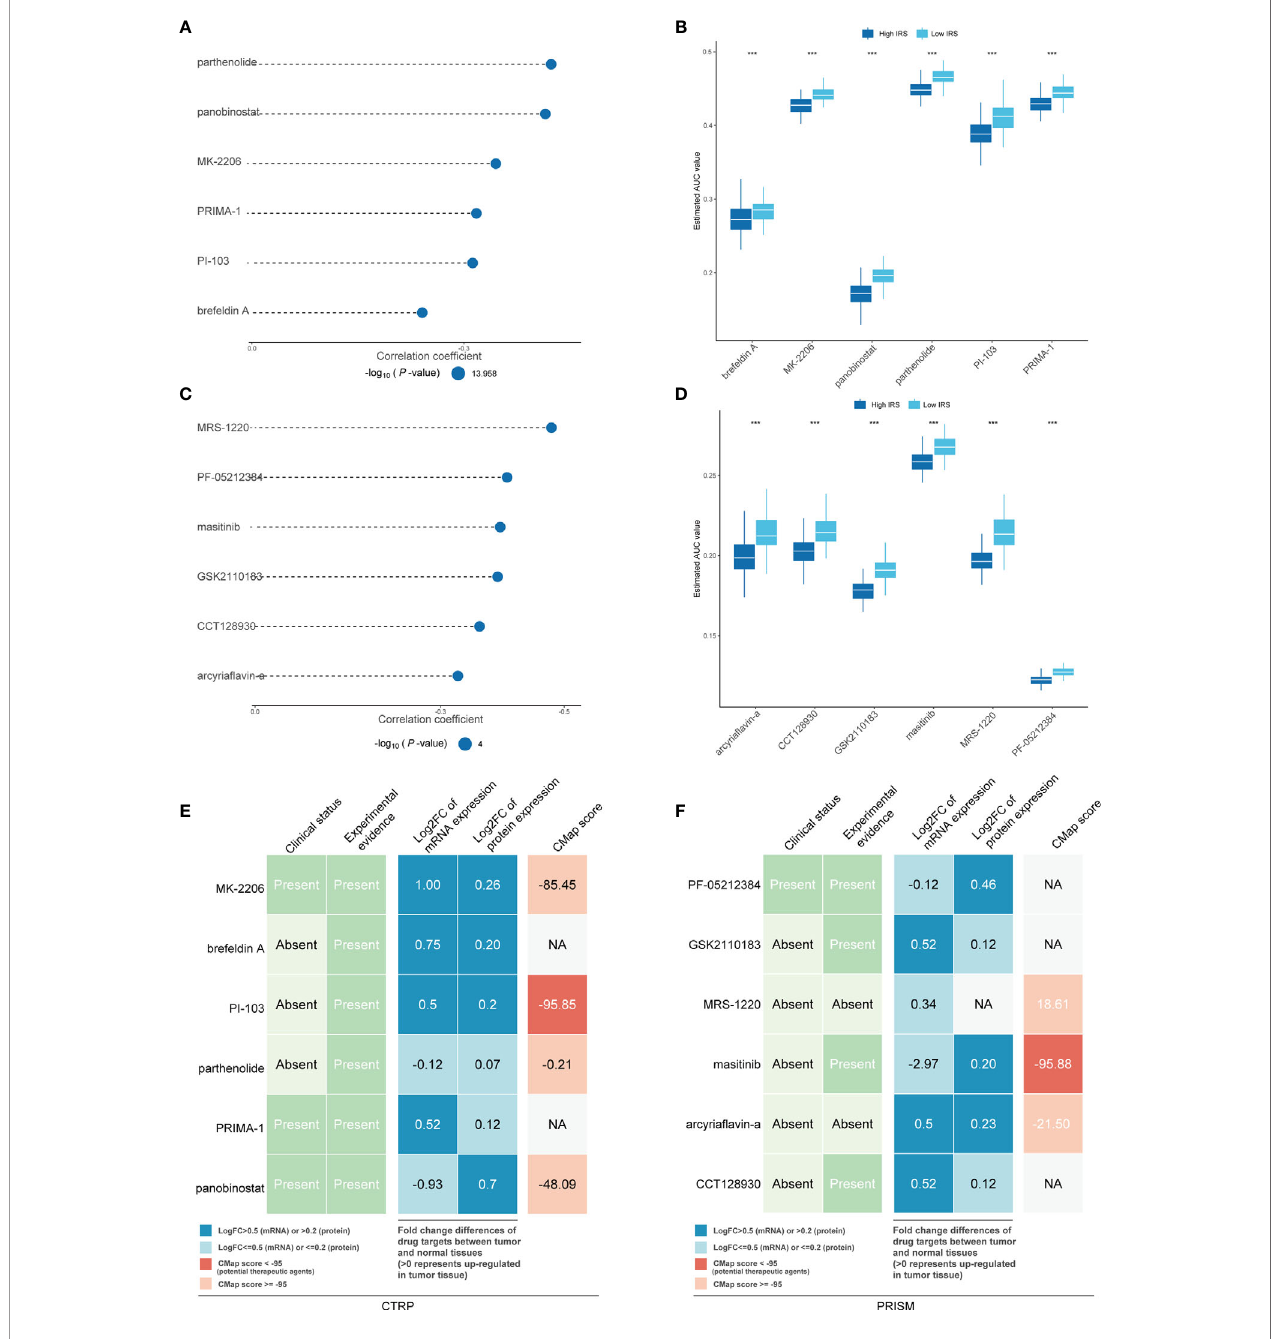
FIGURE 9 | Identi fi cation of candidate agents with higher drug sensitivity in high-IRS patients. The bubble plot shows the degree of negative correlation between AUC values and IRS scores of six CTRP-derived compounds (A) and six PRISM-derived compounds (C) , with longer lines representing stronger negative correlations and implying greater drug sensitivity. The results of differential drug response analysis of CTRP-derived compounds (B) and six PRISM- derived compounds between the IRS-high and IRS-low groups (D) . Note that lower values on the y-axis of boxplots imply greater drug sensitivity. Evidence from multiple sources to identify the most promising therapeutic agents for the high-IRS group. Six CTRP-derived agents (E) and six PRISM-derived agents (F) are shown on the left and right of the diagram, respectively. *** means the p-value is less than 0.01; NA means Not